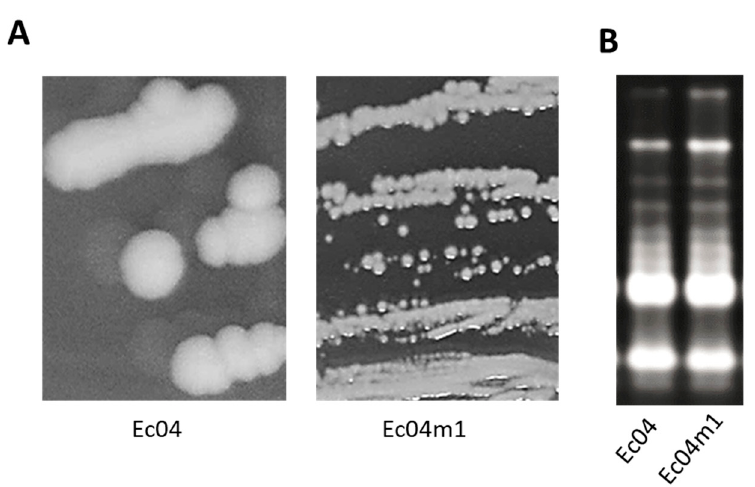
Figure 1. ( A ) Colony morphotypes obtained after plating of Ec04 biofilm exposed to PHMB over 9 days. Ec04m1 corresponds to a small colony variant. ( B ) ERIC-PCR profiles of Ec04 and Ec04m1.